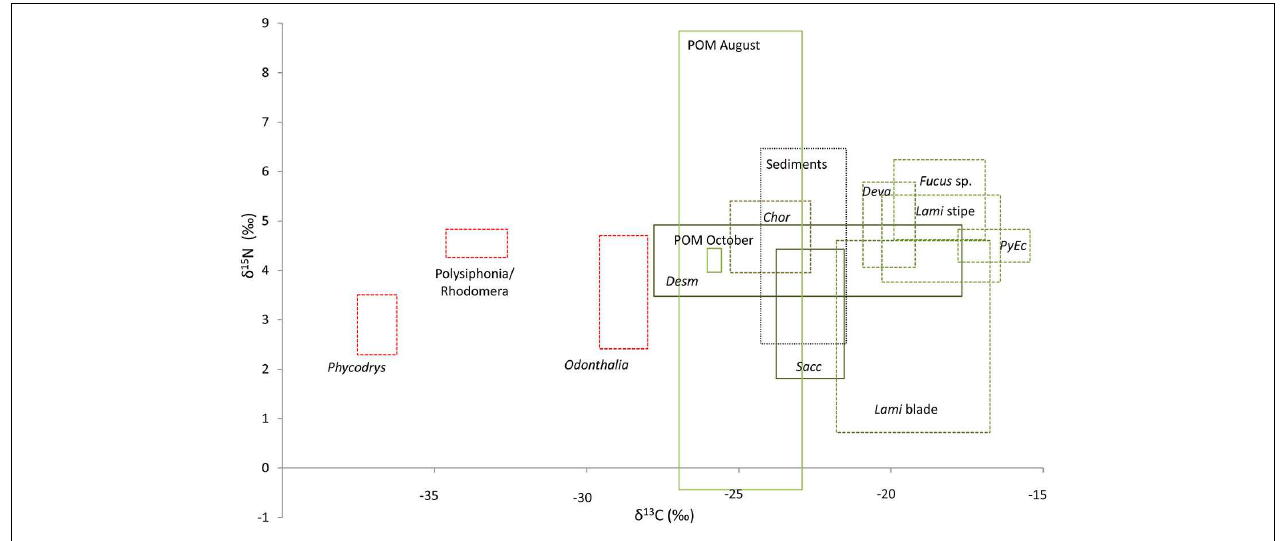
FIGURE 2 | Isotopic distribution of all collected carbon sources. The boxes represent the full range of data from all replicates of the respective carbon sources (maximum and minimum δ 13 C and δ 15 N). Abbrevations are as follows Chor, Chorda filum; Desm, Desmarestia